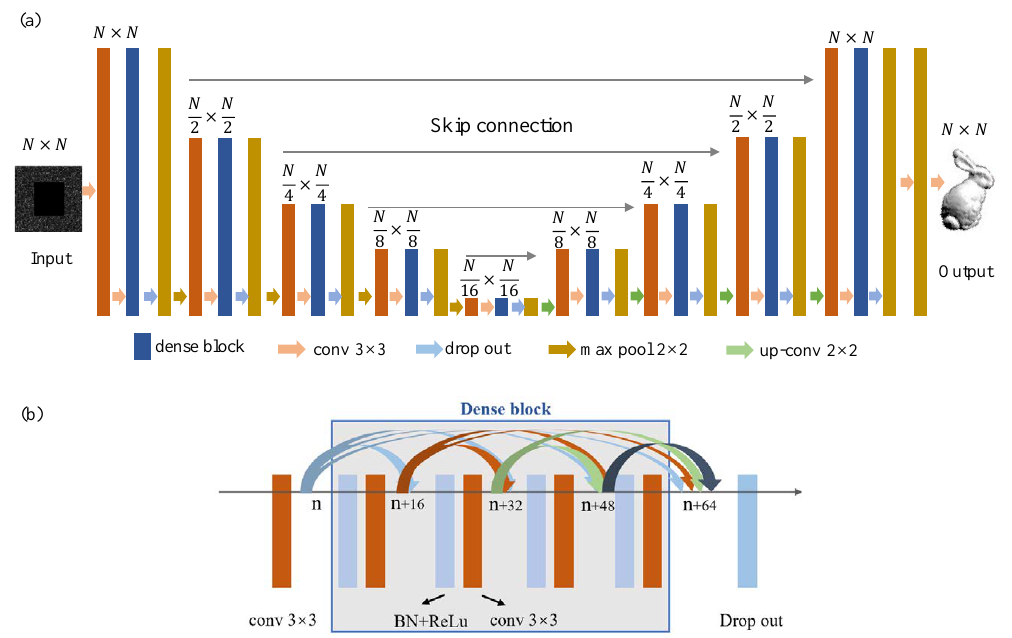
Figure 2. Detailed architecture of the neural network. ( a ) structure of the reconstruction model; ( b ) structure of the dense